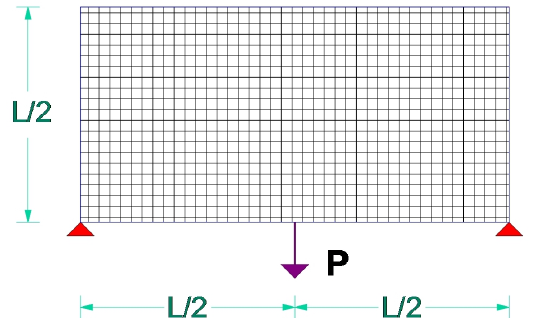
Figure 11. Definition of test example D.